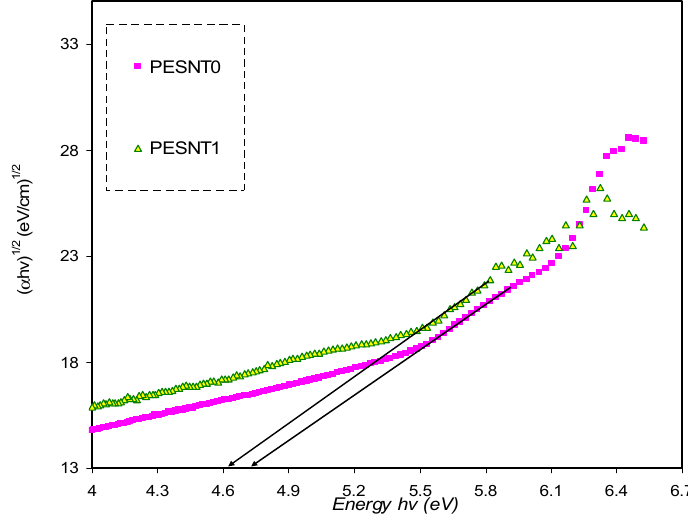
Figure 8. ( α h υ ) 1 / 2 in opposition to energy of photon for pure PEO (PESNT0) and doped (PESNT1) samples.